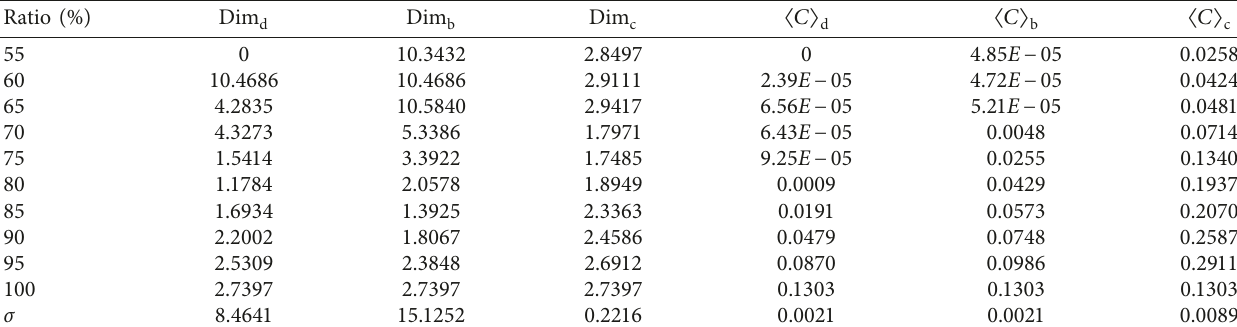
Table 6: Box dimension and cluster coefficient of YPI network with nodes removal in the descending